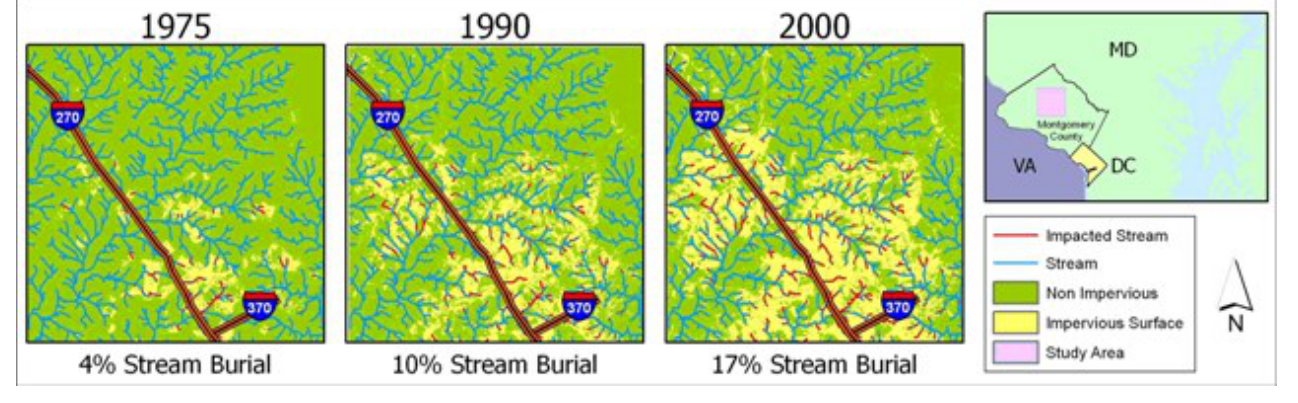
Fig. 6. Estimates of stream burial for a rapidly developing region within the Potomac River basin north of Washington,